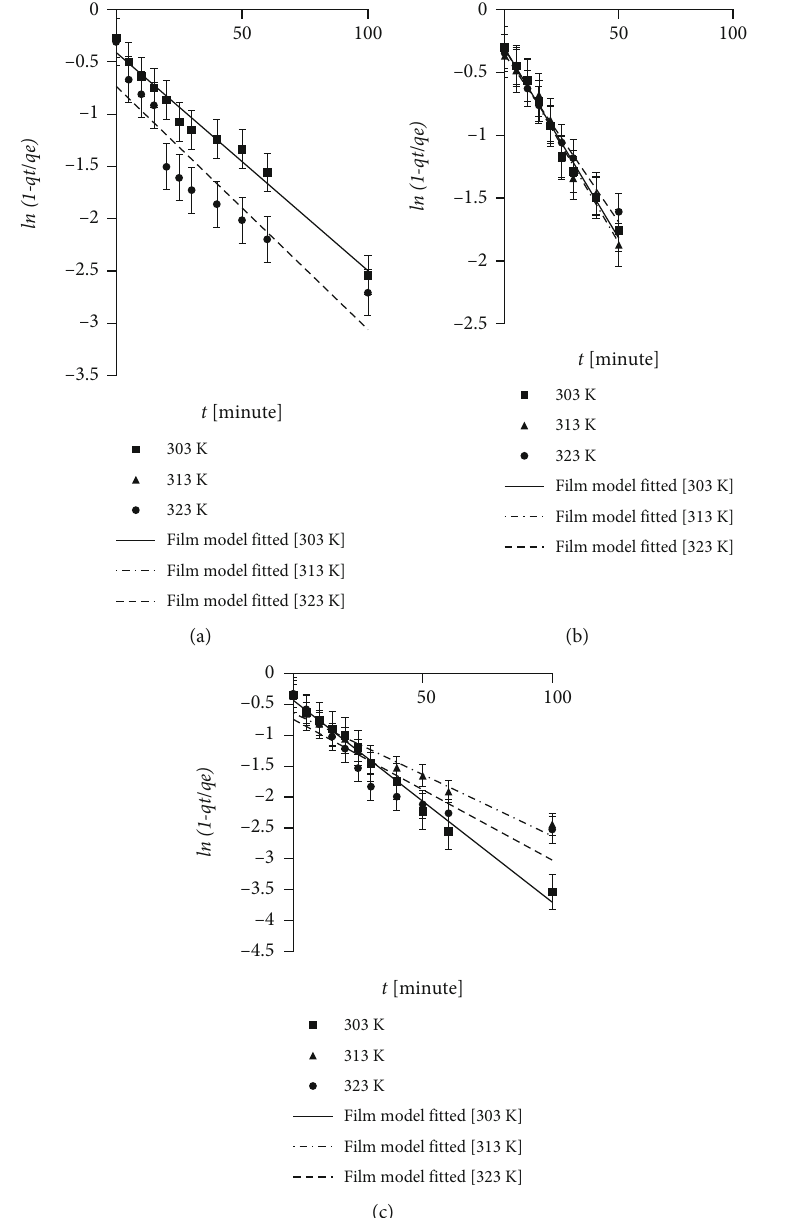
Figure 18: Data kinetics fi t of Film di ff usion model with CV concentrations of (a) 50 ppm, (b) 100ppm, and (c) 200